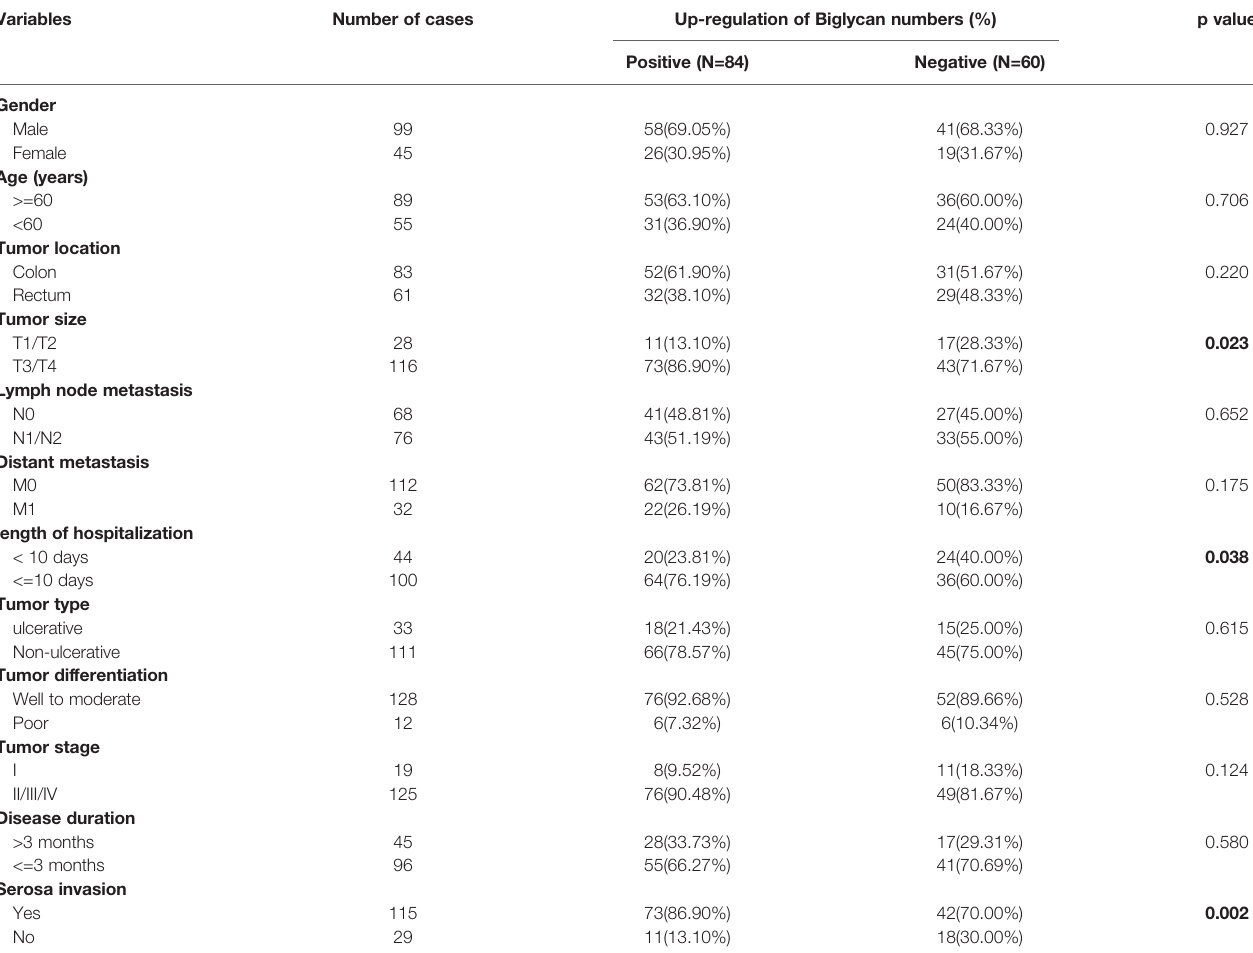
TABLE 1 | Association between BGN expression and clinicopathological factors of colon cancer